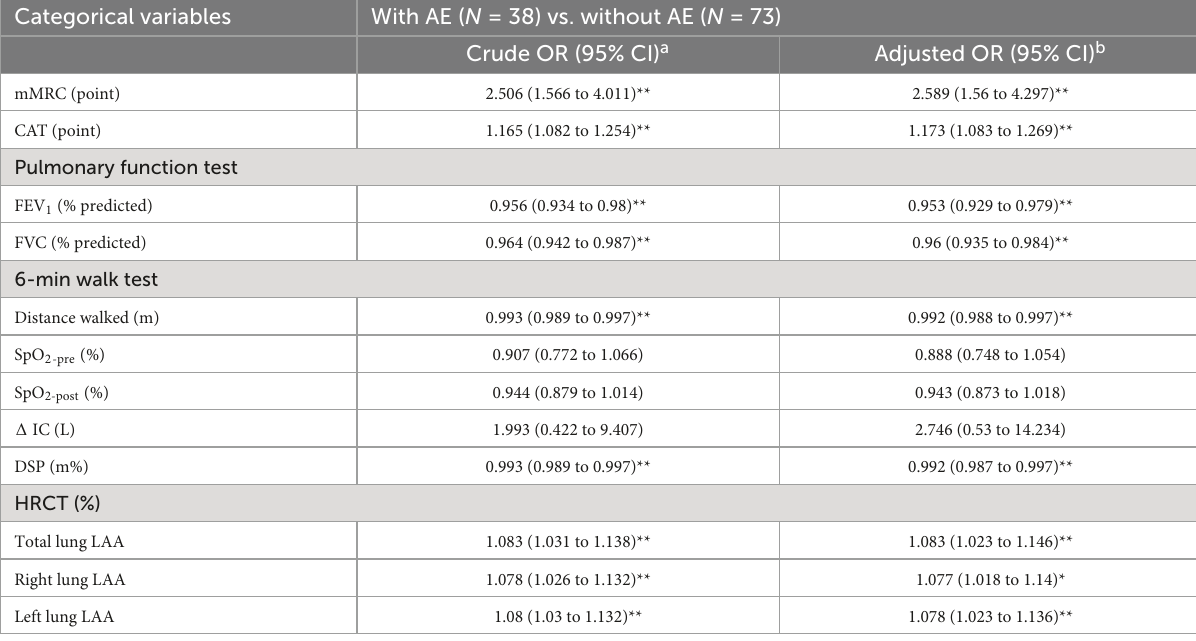
TABLE 5 Associations (odds ratios, ORs) of details of life quality, dyspnea sensation level, pulmonary function test parameters, low-attenuation area percentage (LAA%), and 6-min walk test outcomes between participants with and those without having acute exacerbation (AE) of chronic obstructive pulmonary disease